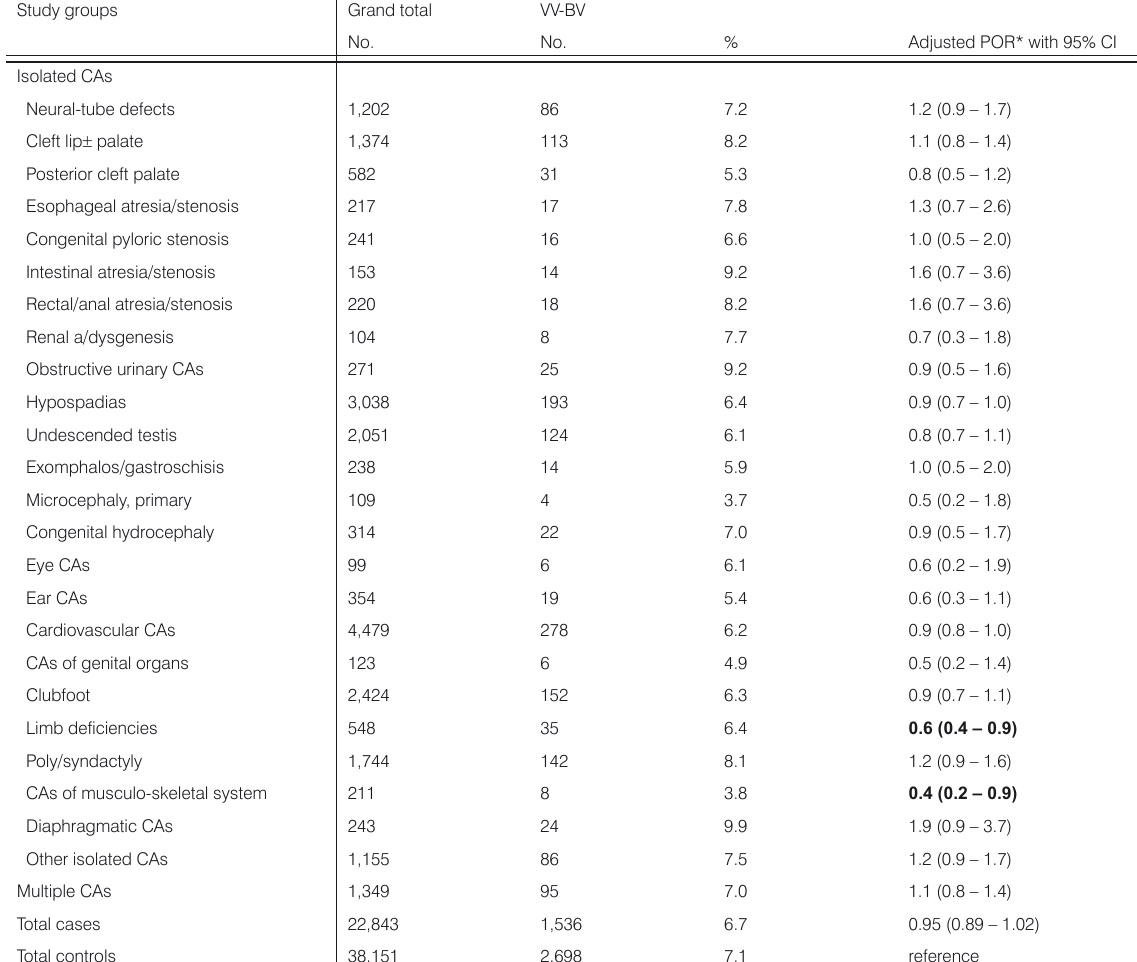
Table 3. Results of multivariate analysis for each case group with different CAs and its all (1-3) matched controls using conditional logistic regression model to estimate adjusted prevalence odds ratio (POR) with 95% confidence interval (CI) of maternal VV-BV (vulvovaginitis- bacterial vaginosis) during the study